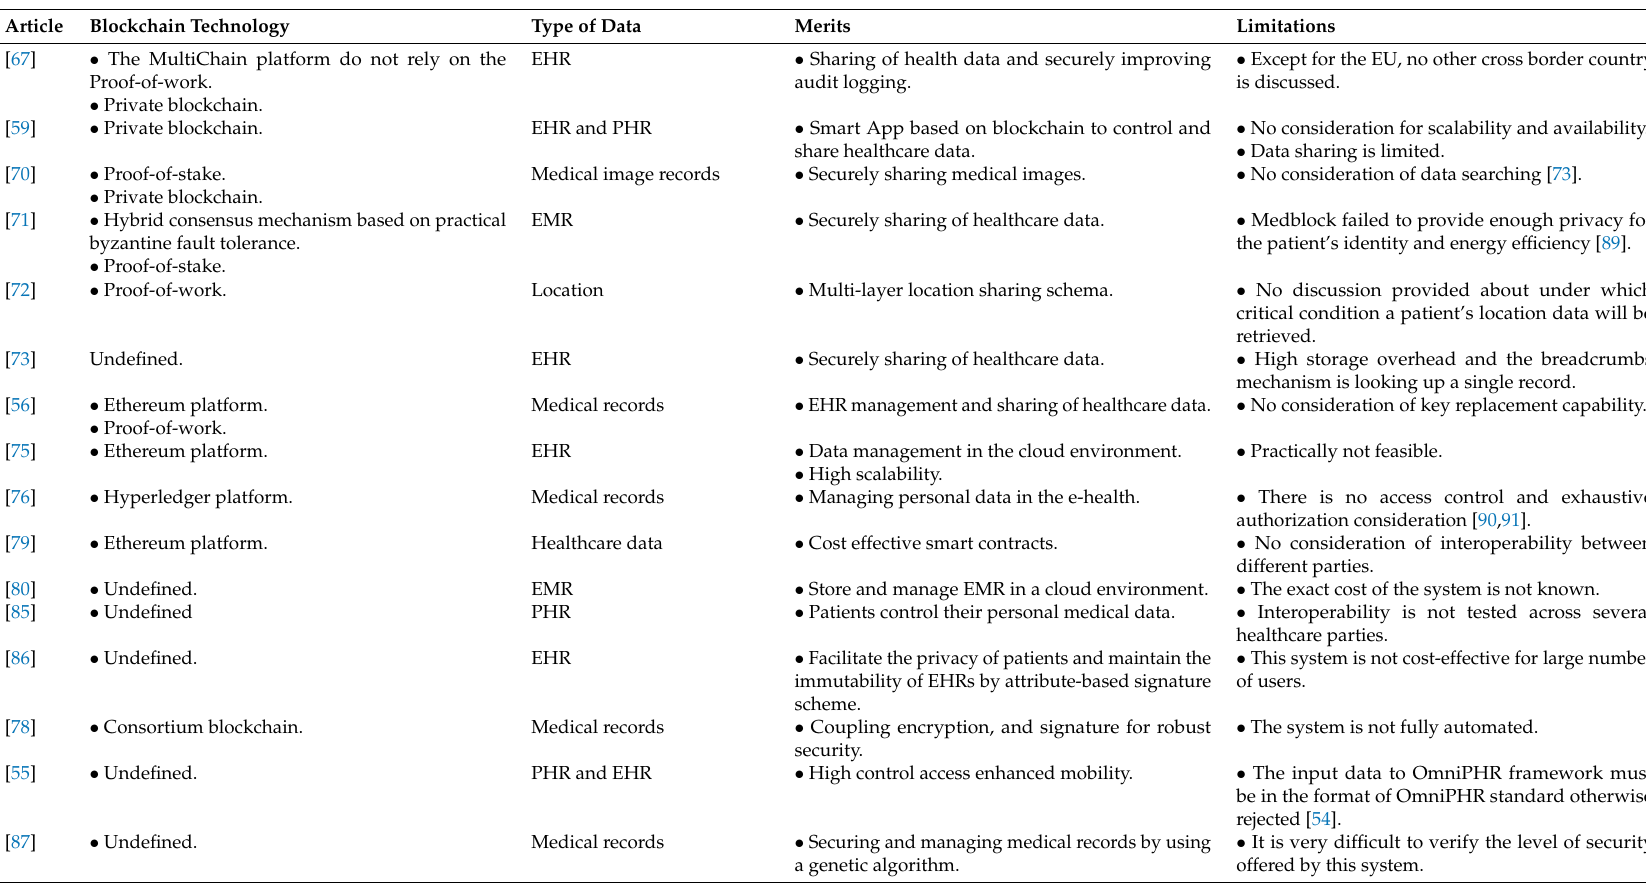
Table 1. Comparison of the data management mechanisms for healthcare in the